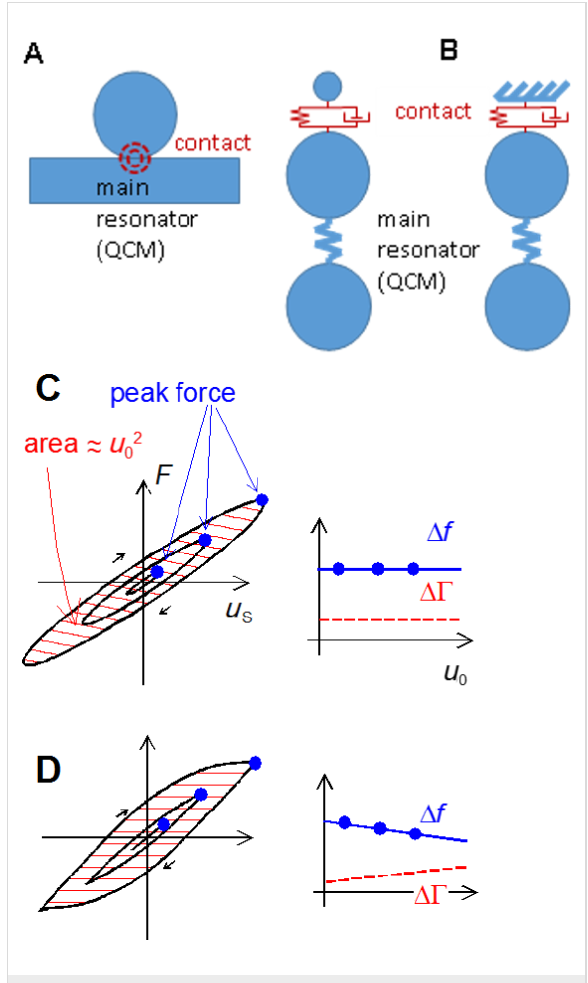
Figure 2: (A) For a narrow contact between a sphere and a plate, deformation occurs close to the contact, only. The contact may be depicted as a spring, or more generally, as a Voigt element, where the latter also accounts for viscous dissipation (B). In the case, where the sphere is heavy enough to be clamped in space by inertia, it can be depicted as a wall (right-hand side in Β ). (C,D): Illustration of how Δ f and ΔΓ depend on the shape of the force–displacement loop. (C): viscoelastic contact and (D): partial slip according to Cattaneo and Mindlin. The frequency shift is roughly proportional to the ratio of force and displacement at the turning point (full dots). ΔΓ is proportional to the area inside the loop divided by u 02 (hatched). (C) and (D) adapted with permission from [10], copyright 2013 the American Physical